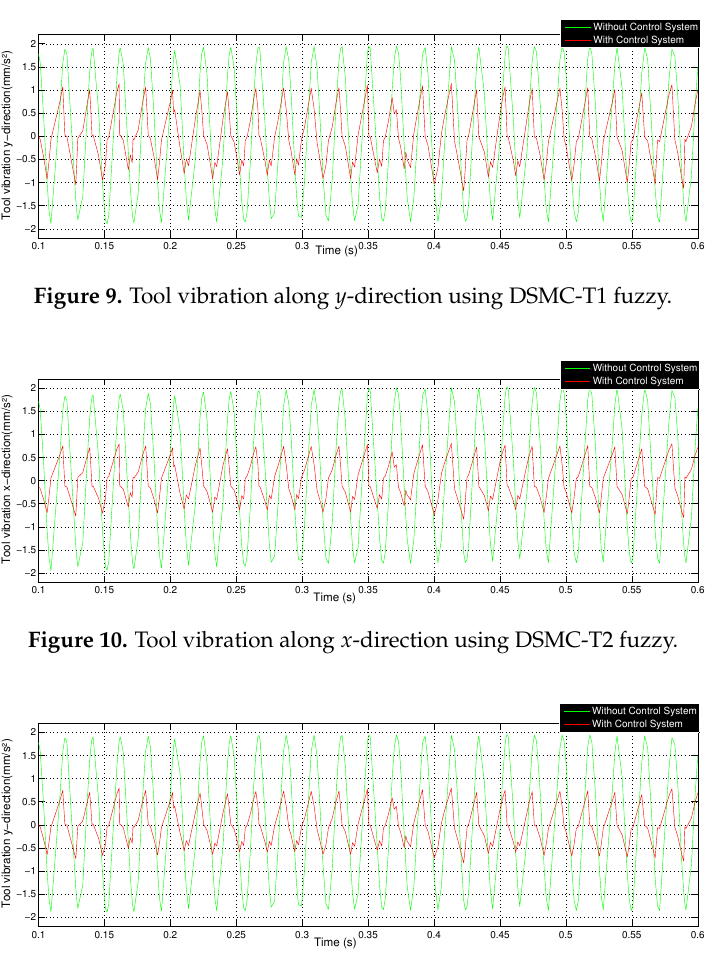
Figure 11. Tool vibration along y -direction using DSMC-T2 fuzzy. Table 2. Average vibration attenuation, mean squared error (MSE)